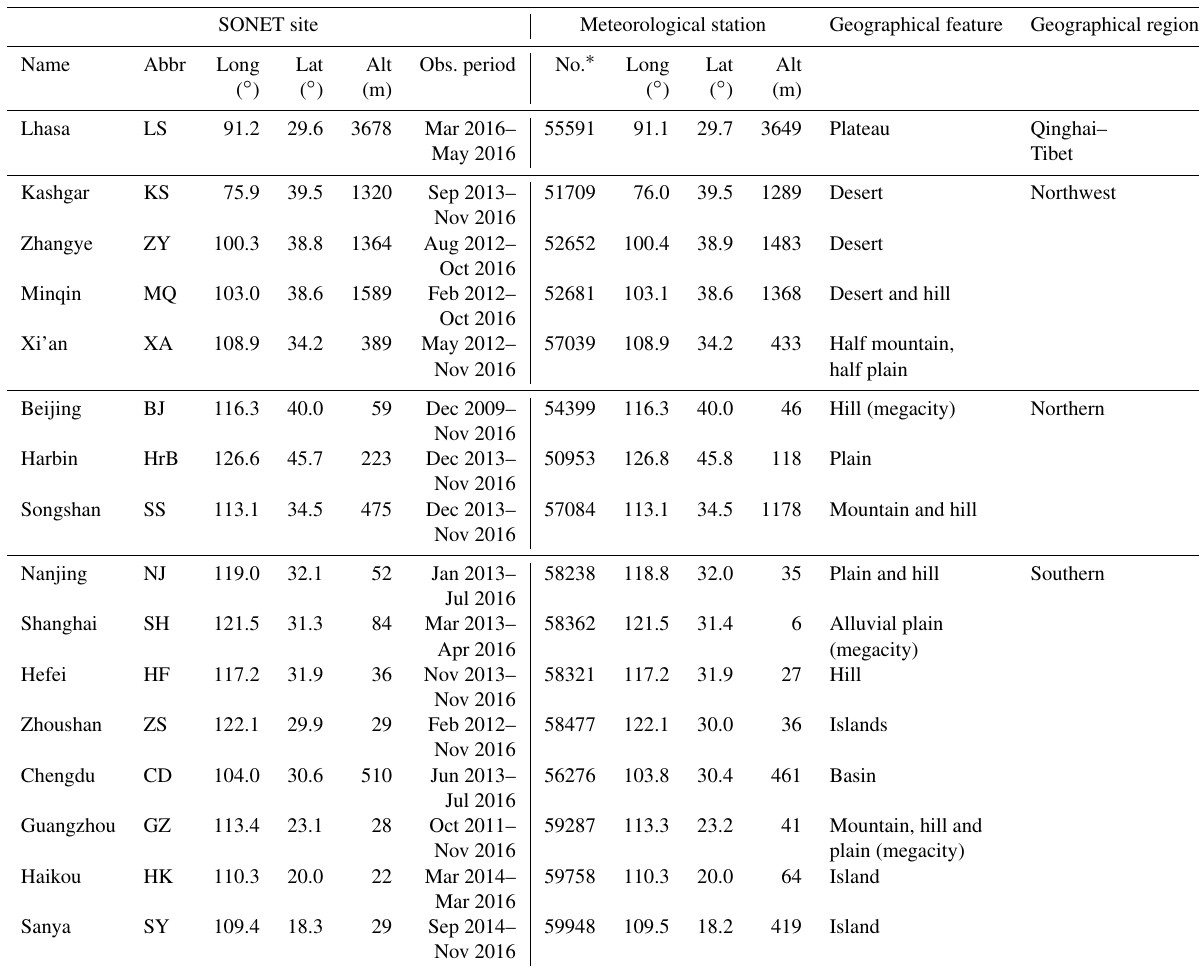
Table 1. SONET sites (name, location and geographical aspects) and meteorological stations used in this study. SONET site Meteorological station Geographical feature Geographical region